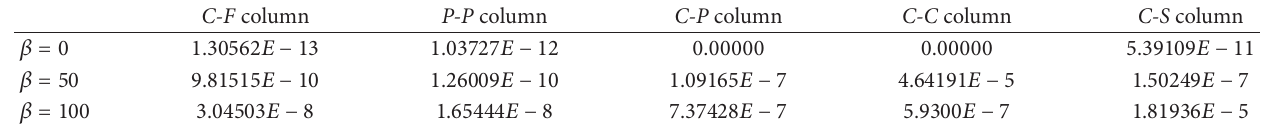
Table 5: Absolute errors of HAM approximations for the first buckling mode.